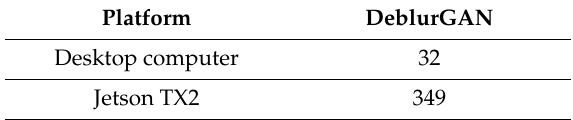
Table 15. Comparison of processing time on Jetson TX2 and desktop computer by DeblurGAN (unit: ms). Platform